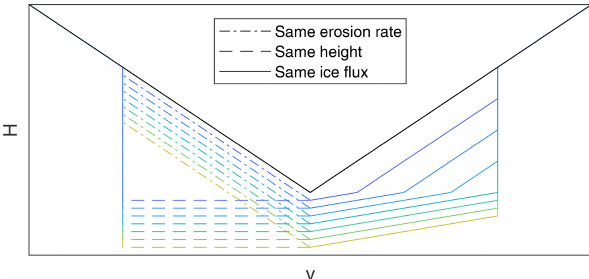
Figure 1. Different concepts of extending erosion from the cardinal flow path to a wider swath in order to transform a V-shaped valley (black line) into a U-shaped valley. Lower lines (from blue to yel- low) describe increasing time. Not to